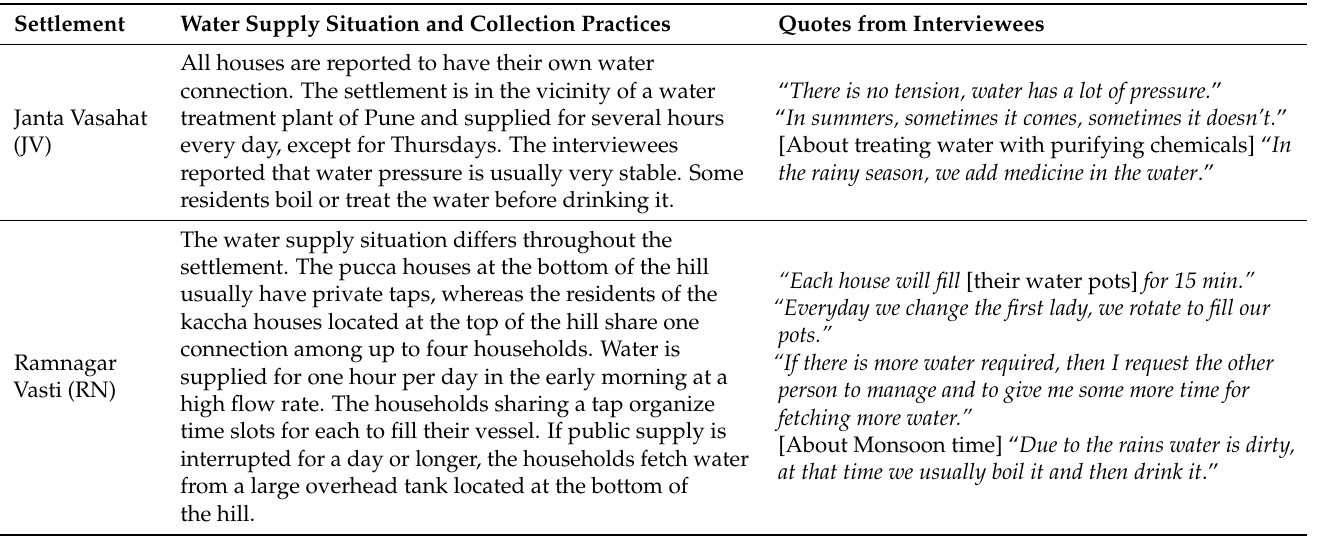
Table A1. Water supply conditions in the sampled